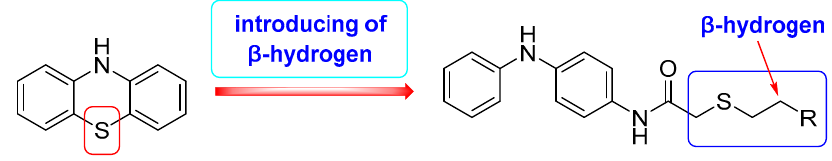
Figure 2. Design of the sulfur-containing 4-aminodiphenylamine derivatives.